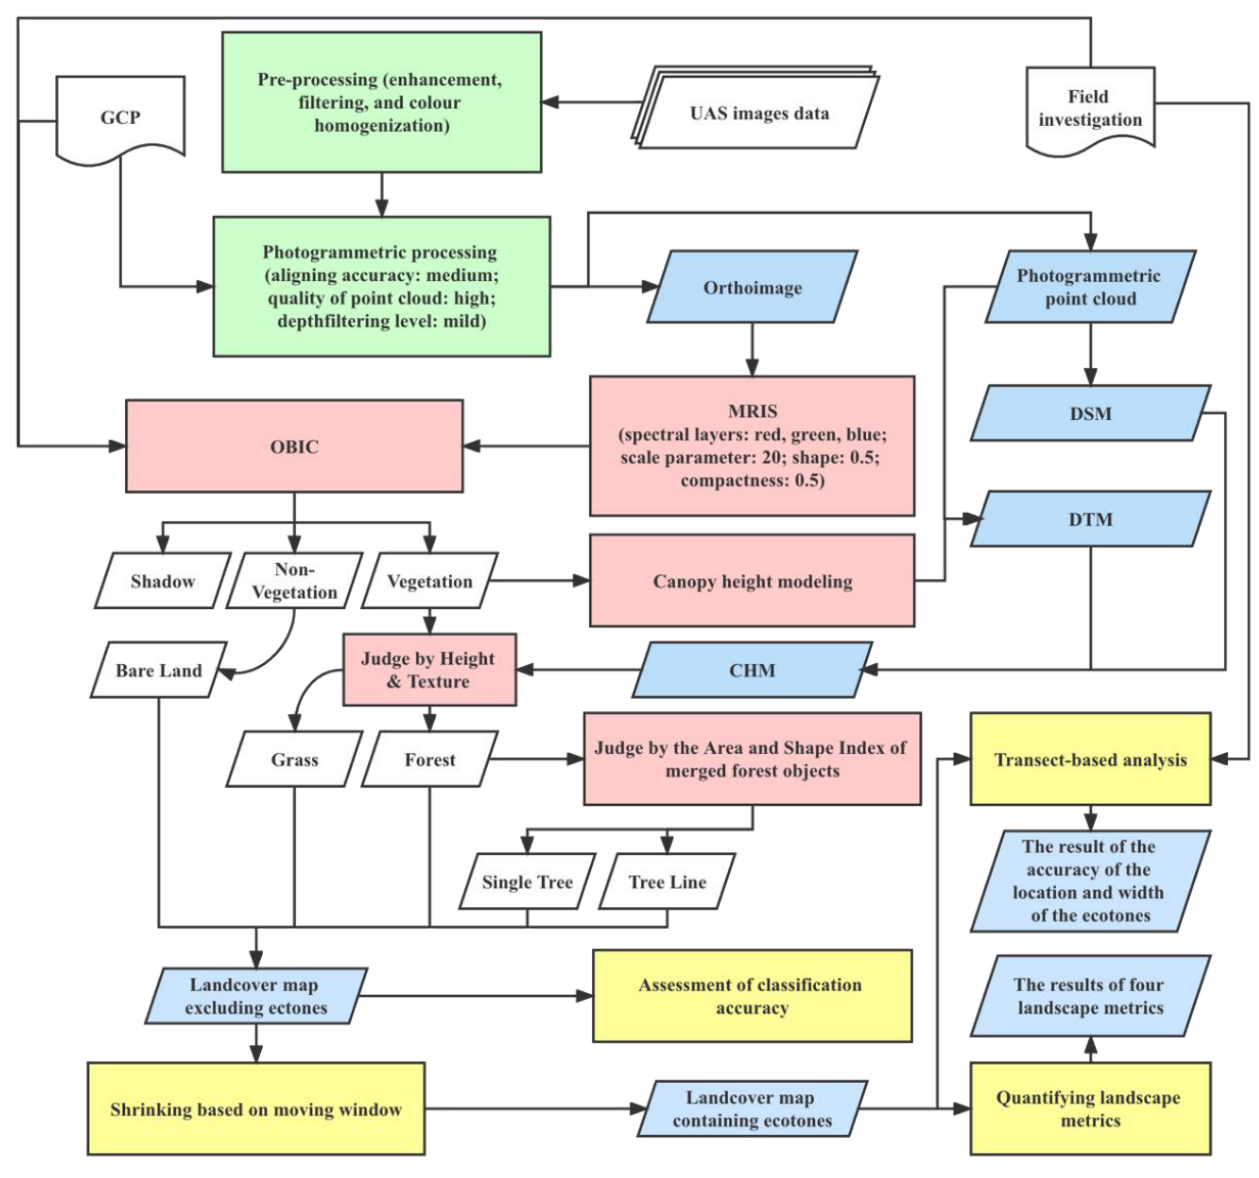
Figure 2. Diagram of detecting and measuring ecotones utilizing UAS images, incorporating a preprocessing flow, a processing workflow of object-based classification, and the CHM extraction workflow. Prepreprocessing is represented by the boxes with a green backdrop. The red-background boxes represent object-based classification processing. Yellow boxes reflect methods for identifying, measuring, and validating ecotones derived from UAS. The parallelograms with a blue background indicate the data or outcomes created by the study framework.